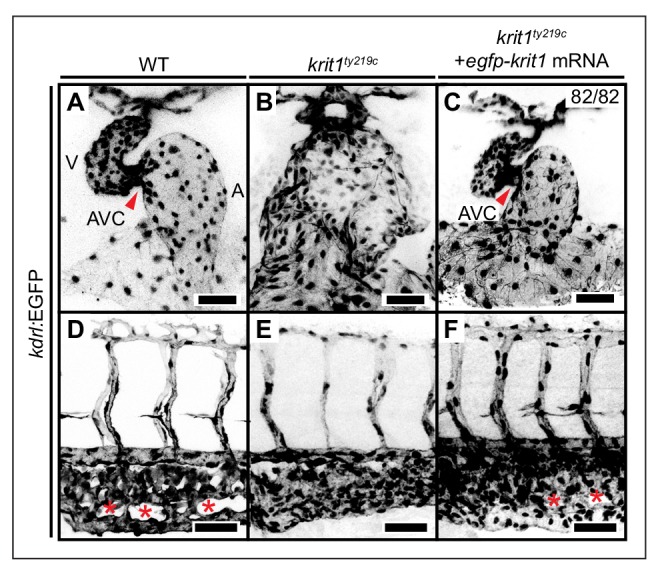
Rescue of krit1ty219c mutant cardiovascular phenotypes by injection of mRNA encoding EGPF-Krit1.(A–C) Projections of confocal z-stack images of (A) 48 hpf wild-type (WT), (B) krit1ty219c mutant, and (C) rescued krit1ty219c mutant hearts marked by Tg(kdrl:EGFP)s843 expression. In comparison to WT, krit1ty219c mutant hearts are dilated and lack the atrioventricular canal (AVC) (red arrowhead). (C) Injection of egfp-krit1 mRNA into krit1ty219c mutants rescues the krit1ty219c mutant cardiac phenotype (n = 82/82 krit1ty219c mutant embryos rescued). (D–F) Projections of confocal z-stack images of 48 hpf caudal plexus regions of the vasculature marked by Tg(kdrl:EGFP)s843 expression. (D) In comparison to the highly branched WT morphology of the caudal vein plexus (red asterisks), (E) the krit1ty219c mutant vasculature has a fused morphology. (F) Injection of egfp-krit1 mRNA into krit1ty219c mutants rescues the krit1ty219c mutant vascular phenotype including a highly branched WT-like caudal vein plexus (red asterisks). A: atrium, V: ventricle. Scale bars are 50 µm.